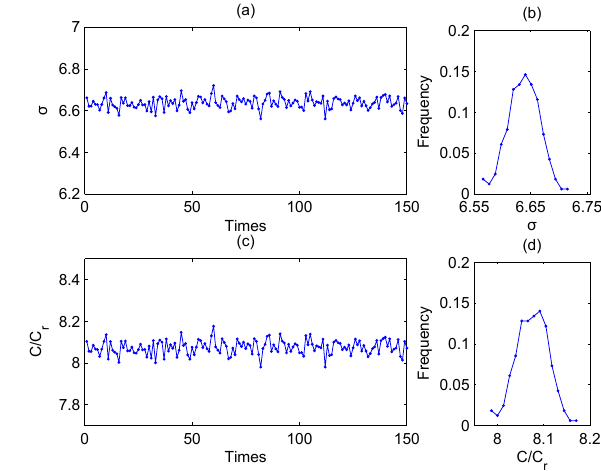
Figure 4. The test of the small-world structure in the ionospheric network. Panel (a) shows the 150 results of σ ; panel (b) shows the frequency of the results of σ ; panel (c) shows the 150 results of C/C r ; panel (d) shows the frequency of the results of C/C r